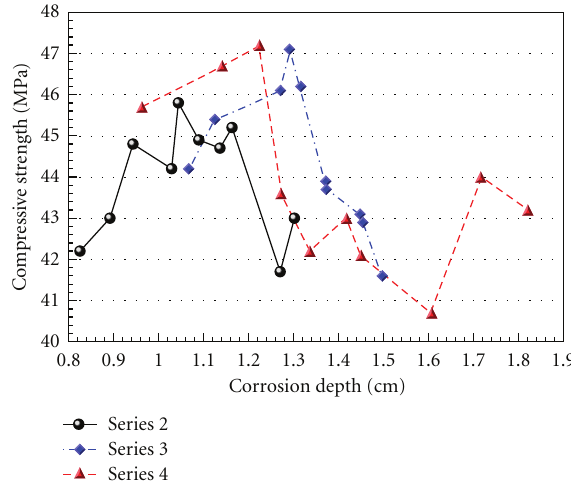
Figure 8: Relation between mass loss ratio and corrosion time.